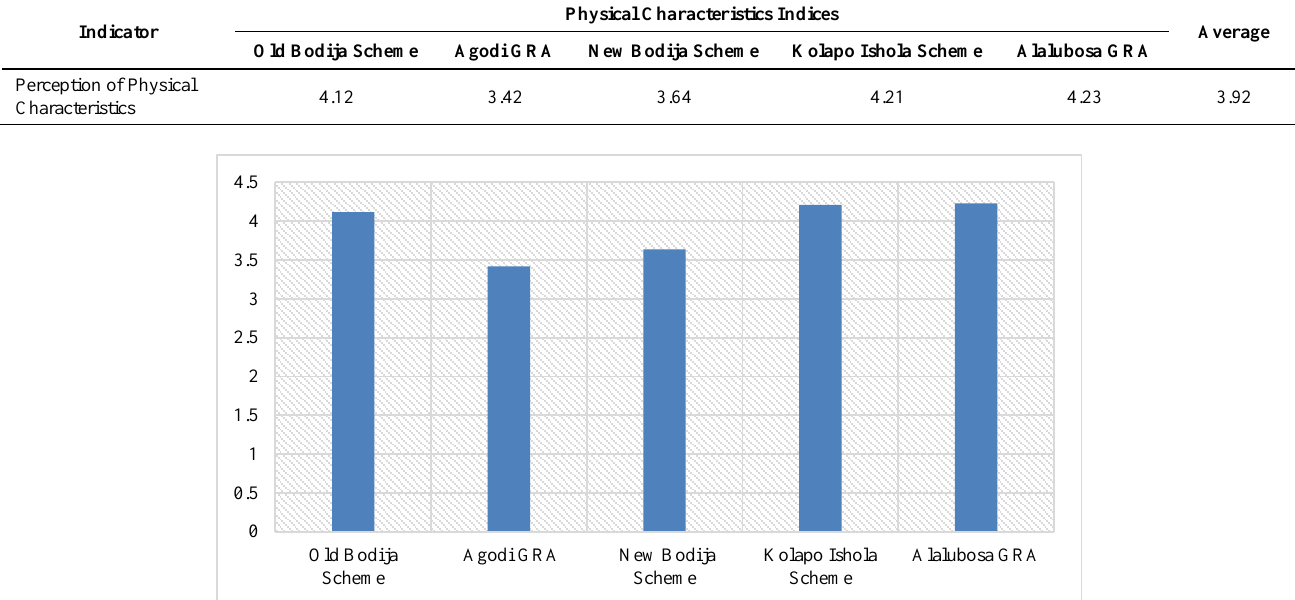
Figure 7. The comparative means of the Physical Quality Indices in the five study